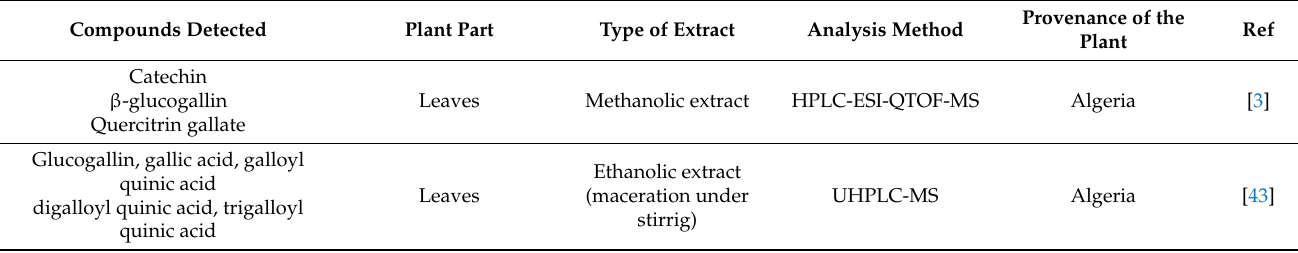
Table 2. Individual phenolic compounds identified in lentisk